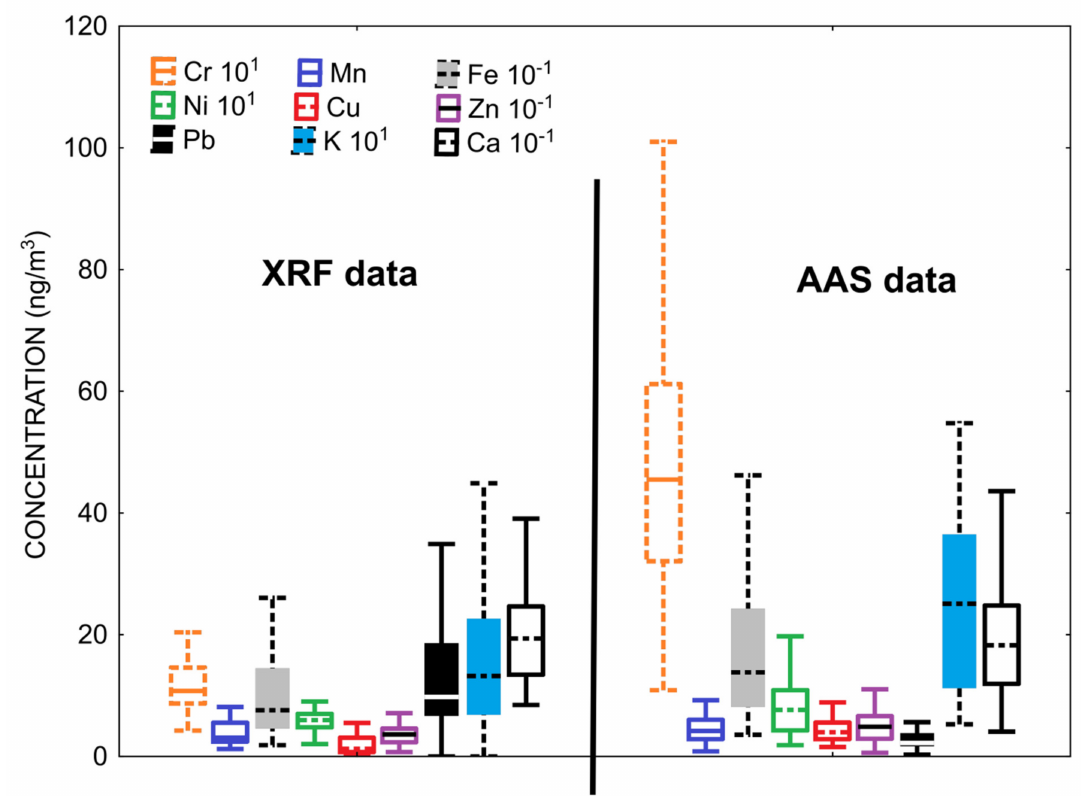
Figure 4. PM10-bound elements data for winter period. Boxes show the range between the 25th and 75th percentiles. The whiskers extend from the edge of the box to the 5th and 95th percentiles of data. The horizontal line inside indicates the median